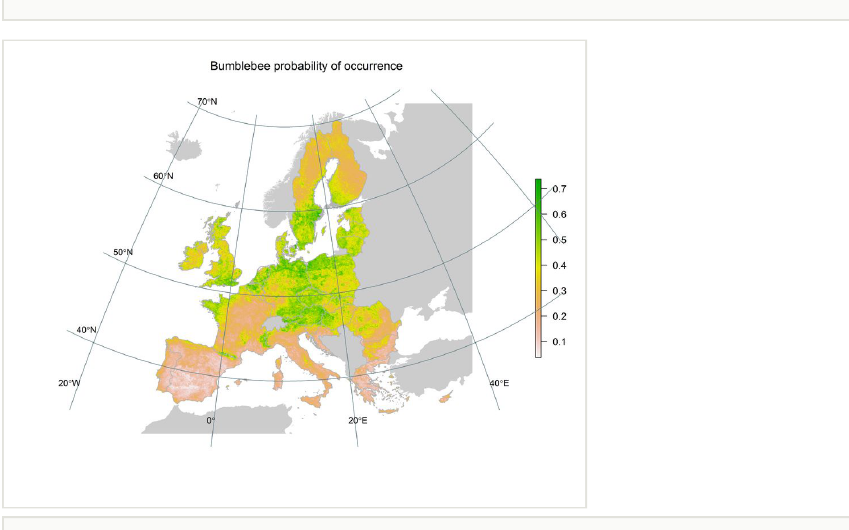
Figure 1. Predicted number of bumblebee species, derived from the sum of each species presence maps. Presence was de fi ned for each species using an individual threshold applied to the predicted probability of occurrence (see main text for details). Values above the threshold were set to 'presence' (1) and values below it to 'absence' (0). The sum of 'presences' indicate, for each locality on the map, the number of bumblebee species potentially present, i.e. the potential species richness.